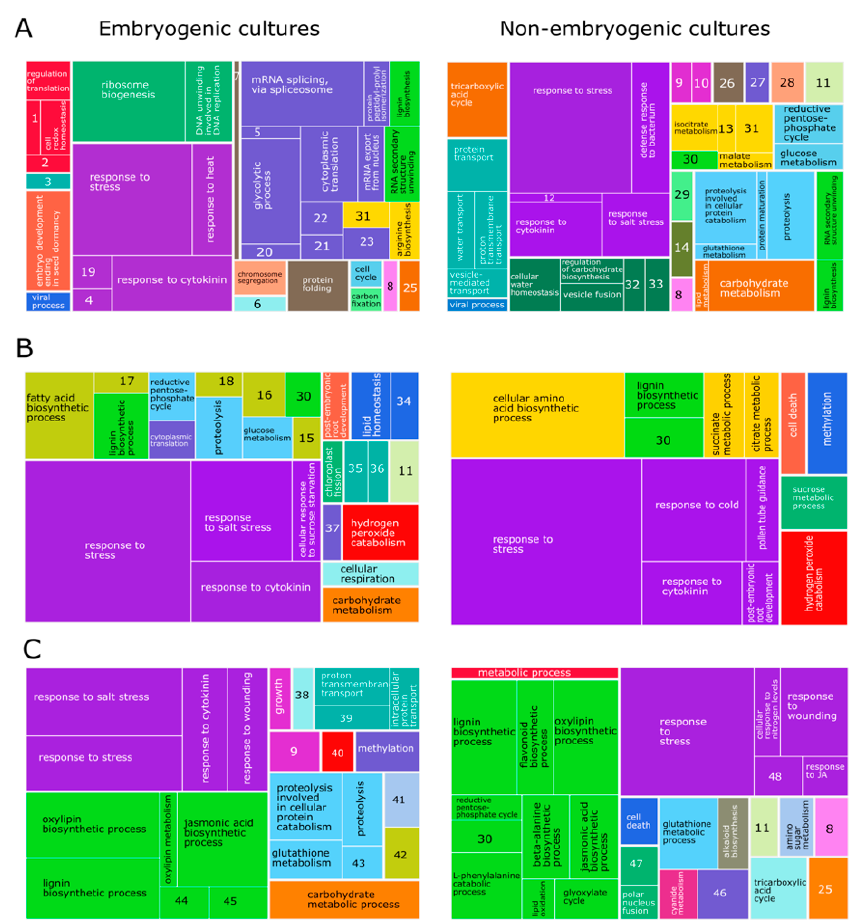
Figure 2. Tree Map of biological process of proteins overaccumulated in EC or NEC based on avail- able proteomics approaches. The gene ontology enrichment of proteins was carried out with DAVID Bioinformatics Resources 6.8 and Revigo (http://revigo.irb.hr/, accessed on 27 September 2021) for reduced visual gene ontology terms. Visual representation of data related to dicots ( A ), monocots ( B ) and gymnosperms ( C ). Numbers in figure: negative regulation of long-day photoperiodism, flowering (1), positive regulation of gene expression (2), metabolic process (3), DNA ligation involved in DNA repair (4), vitamin E biosynthesis (5), microtubule-based process (6), protein refolding (7), biosynthetic process (8), unidimensional cell growth (9), seed coat development (10), photorespiration (11), pyrimidine nucleobase metabolism (13), photosynthesis (14), ‘de novo’ GDP-L-fucose biosyn- thetic process (15), ‘de novo’ pyrimidine nucleobase biosynthetic process (16), wax biosynthesis (17), cell wall pectin metabolism (18), response to other organism (19), amylopectin biosynthesis (20), starch biosynthesis (21), DNA replication (22), transcription by RNA polymerase I (23), chromosome segregation (24), carbohydrate metabolism (25), protein folding (26), ATP metabolic process (27), selenium compound metabolism (28), glycerol-3-phosphate metabolism (29), one-carbon metabolism (30), cellular amino acid biosynthesis (31), cell plate assembly (32), actin filament bundle assembly (33), positive regulation of RNA polymerase II transcription preinitiation complex assembly (34), protein targeting to chloroplast (35), calcium ion transmembrane transport (36), glycosyl compound metabolism (37), cortical microtubule organization (38), intra-Golgi vesicle-mediated transport (39), cell redox a homeostasis (40), amino sugar metabolism (41), dTDP-rhamnose biosynthesis (42), gly- coside Catabolism (43), L-ascorbate biosynthesis (44), (R)-2-hydroxy-alpha-linolenate biosynthesis (45), mRNA splicing, via spliceosome (46), heterochromatin organization (47), heterochromatin organization